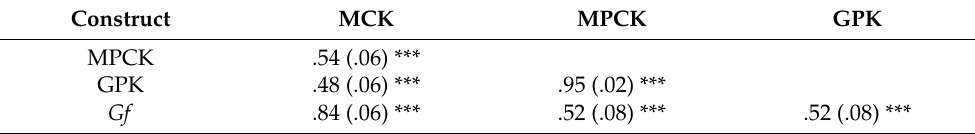
Table 2. CFA model with correlated first-order factor: latent correlations and standard errors (in